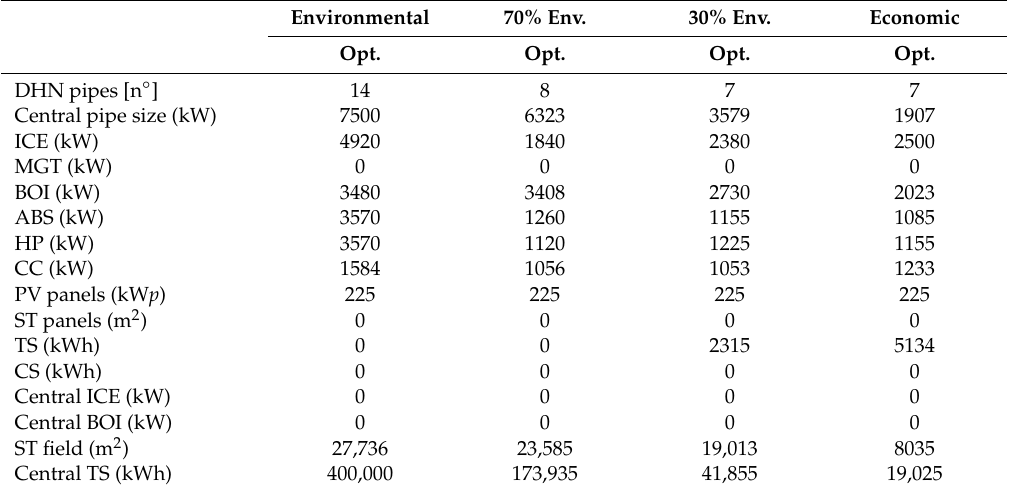
Table 12. Optimal configurations of the distributed generation solutions Integrated with central solar